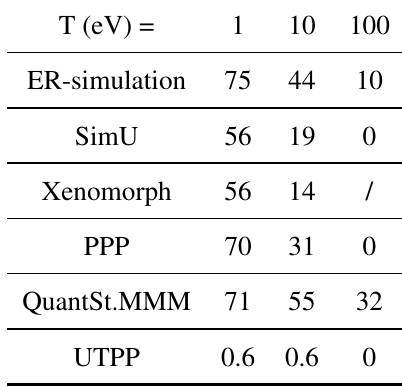
Table 1. The relative dip ( % ) measured on the Lyman- (cid:12) line from the different codes for n = 10 17 cm (cid:0) 3 e